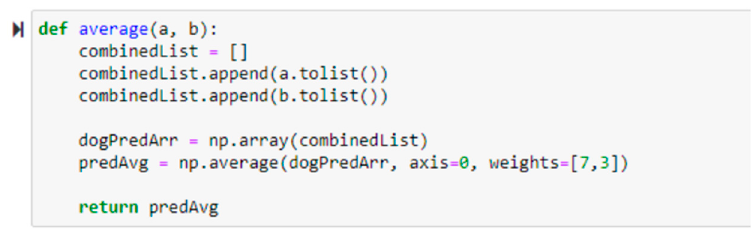
Figure 7. Functions are used to perform weighted average calculations.